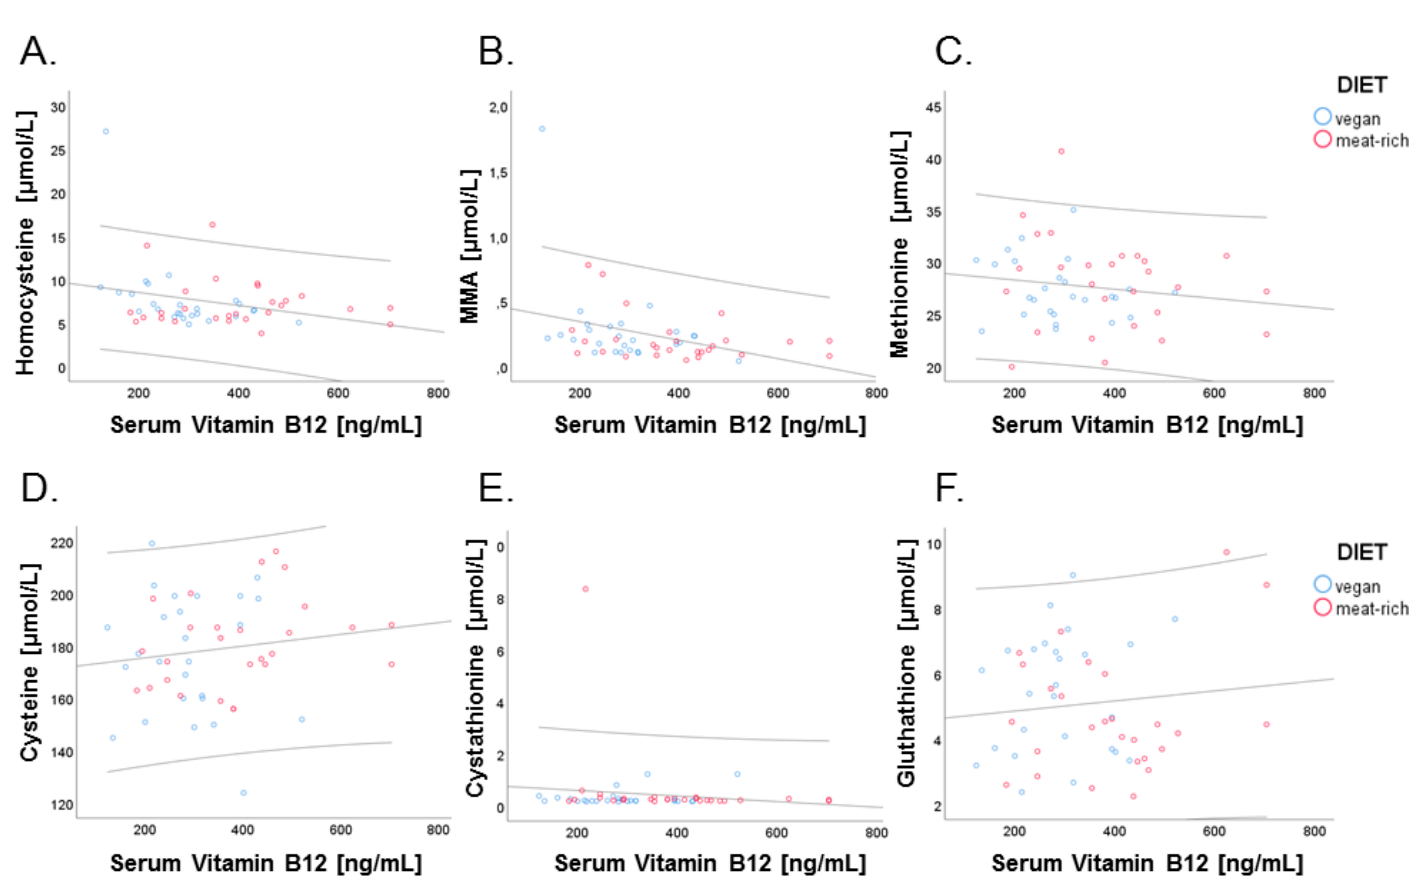
Figure 6. Relationship of serum vitamin B 12 with cellular markers of vitamin B 12 , tHcy, and MMA, and with other marker metabolites of B-vitamin status. Data points of participants in the vegan and meat-rich diets are shown as blue and red dots, respectively. Correlations are shown for serum vitamin B 12 (ng / L) and total homocysteine ( µ mol / L; r = 0.280, p = 0.042) (Panel A ), serum vitamin B 12 and methylmalonic acid ( µ mol / L; r = 0.280, p = 0.042) (Panel B ), serum vitamin B 12 and methionine ( µ mol / L; r = − 0.154, p = 0.272) (Panel C ), serum vitamin B 12 and serum cysteine ( µ mol / L; r = 0.147, p = 0.293) (Panel D ), serum vitamin B 12 and cystathionine ( µ mol / L; r = − 0.126, p = 0.367) (Panel E ), and serum vitamin B 12 and glutathione ( µ mol / L; r = 0.110, p = 0.434) (Panel F ). Dispersion lines show the 95% confidence interval of the linear regression fit.